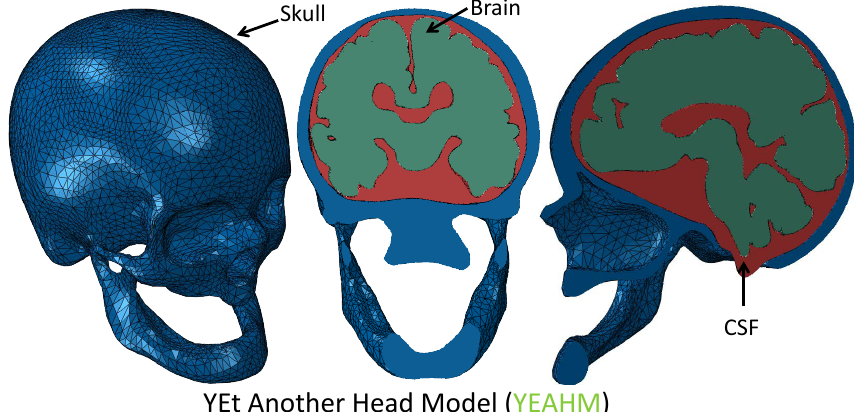
Figure 7. YEAHM consists of skull (blue), CSF (red) and brain